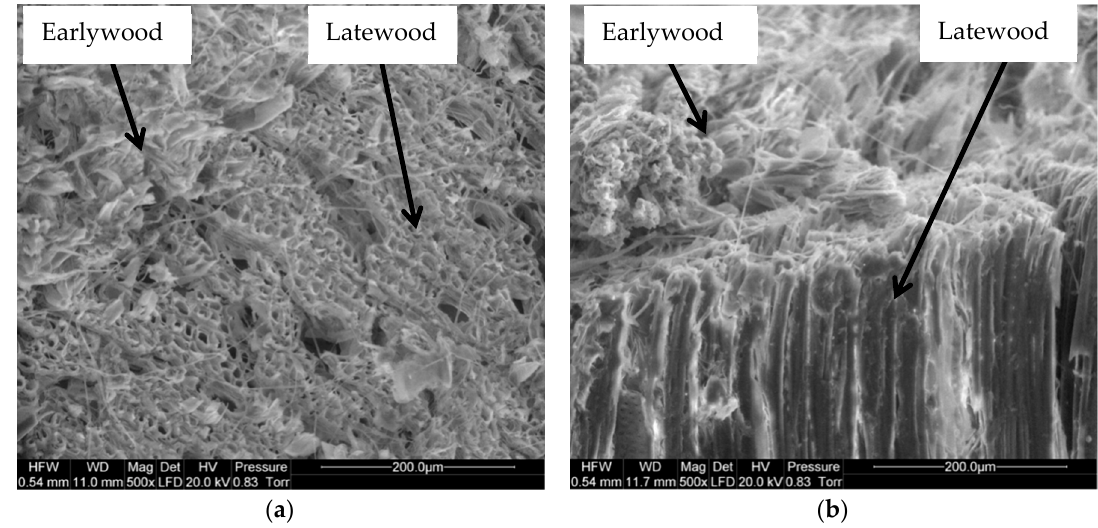
Figure 4. SEM image of a saw-cut surface of black poplar: ( a ) transverse section, ( b ) longitudinal section.